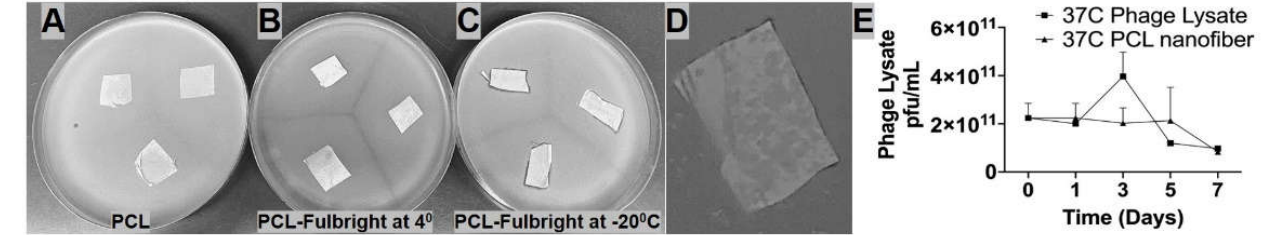
Figure 4. Panels A–D represent nanofibers stored at different temperatures and time periods. ( A ) PCL nanofiber at 4 °C stored for 7 days, ( B ) PCL_Fulbright at 4 °C for 7 days, ( C ) PCL_Fulbright at −20 °C stored for 7 days ( D ) PCL_Fulbright at −20 °C stored for 11 months. ( E ) Stability of phage particle with PCL nanofiber. All nanofibers were plated on M. smegmatis lawn. Arrows are pointing to a clear zone formed by phage lysis of host bacteria.